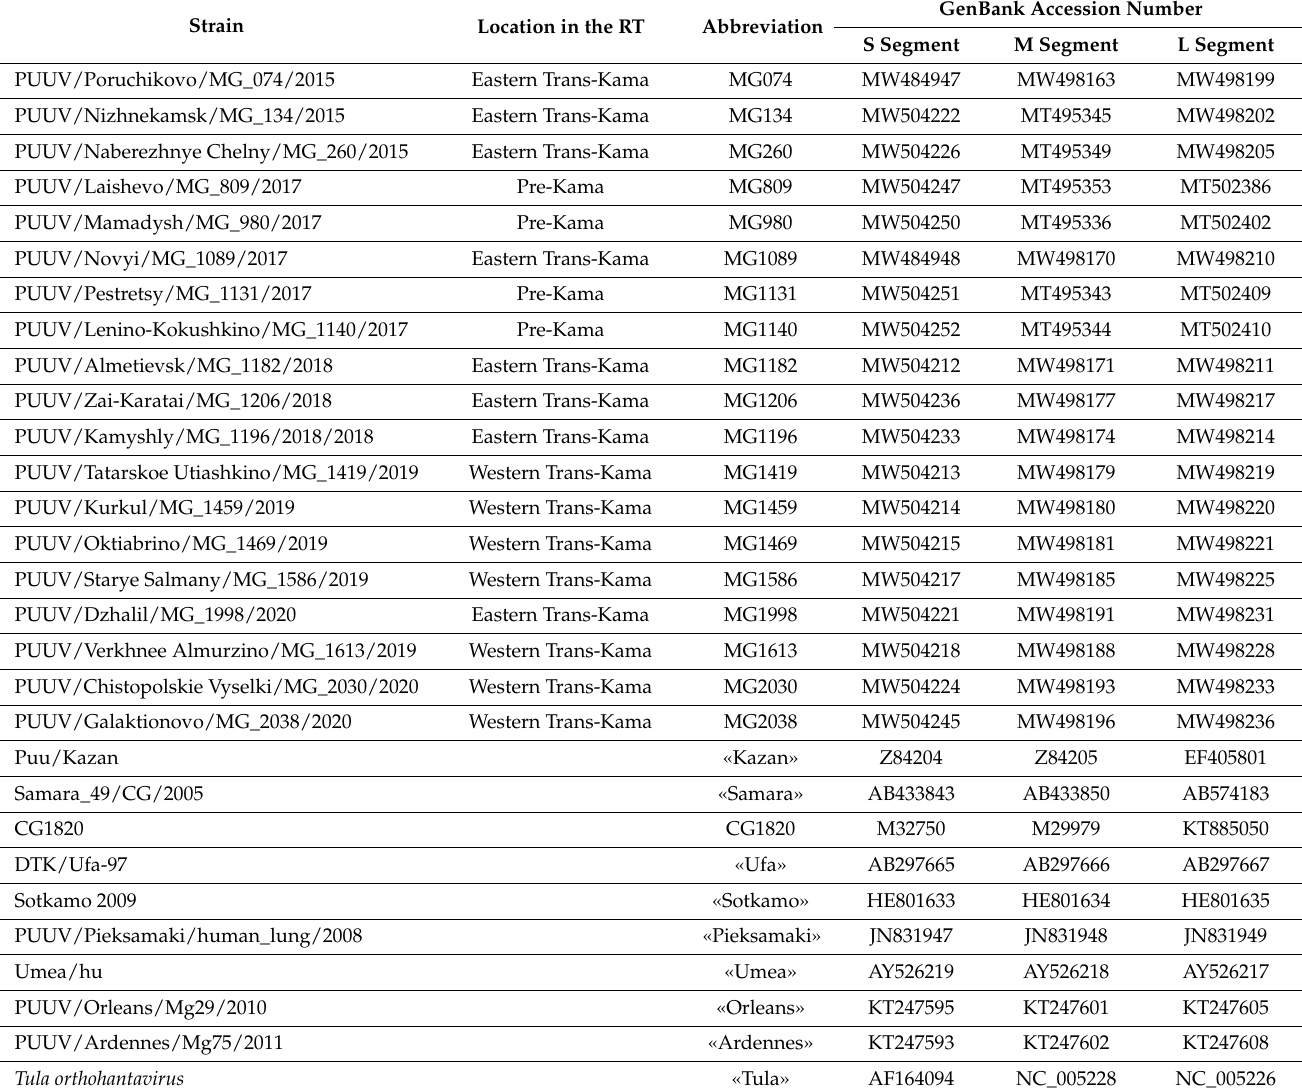
Table 1. The list of PUUV strains and Tula orthohantavirus obtained from GenBank database and used for comparison analysis in this